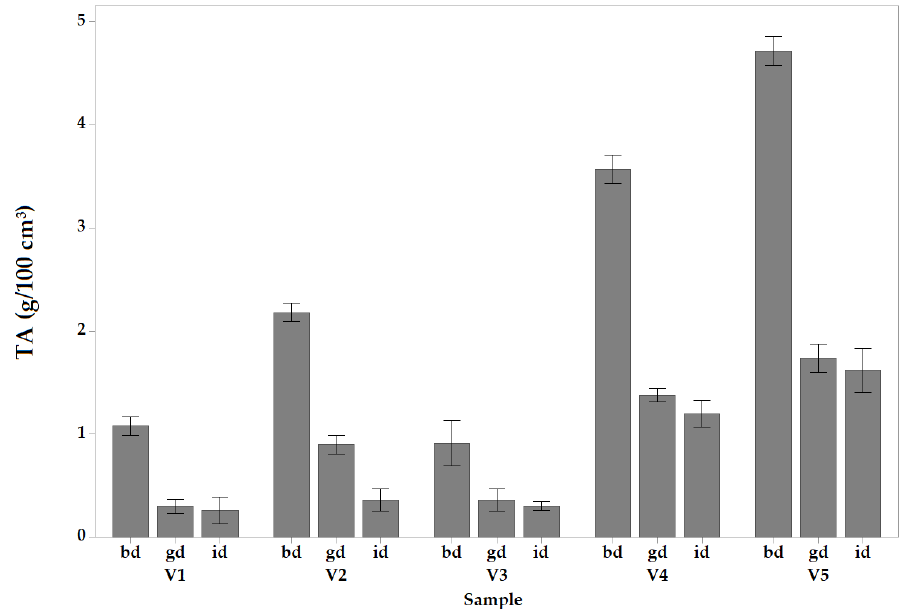
Figure 3. Interval plots of total acidity (TA) vs. samples before digestion (bd); and after gastric digestion (gd); intestinal digestion (id). V1 = banana peel vinegar aged for 1 year, produced without boiling the peels boiling aged for 1 year, V2 = banana peel vinegar aged for 3 years, produced without boiling the peels boiling aged for 3 years, V3 = banana peel vinegar aged for 2 years, produced with peels boiling the peels aged for 2 years, V4 = commercial balsamic vinegar produced from concentrated apple juice and caramel aged in oak barrels for 1 year, V5 = Modena commercial vinegar obtained from concentrated grape must. The error bars represent a 95% confidence interval for the mean. The levels of soluble solids including sugar, salts and proteins in an aqueous sample are indicated by Brix (%) parameter. In general, this parameter indicated sugar equiva- lents in samples omitting other soluble materials [30].